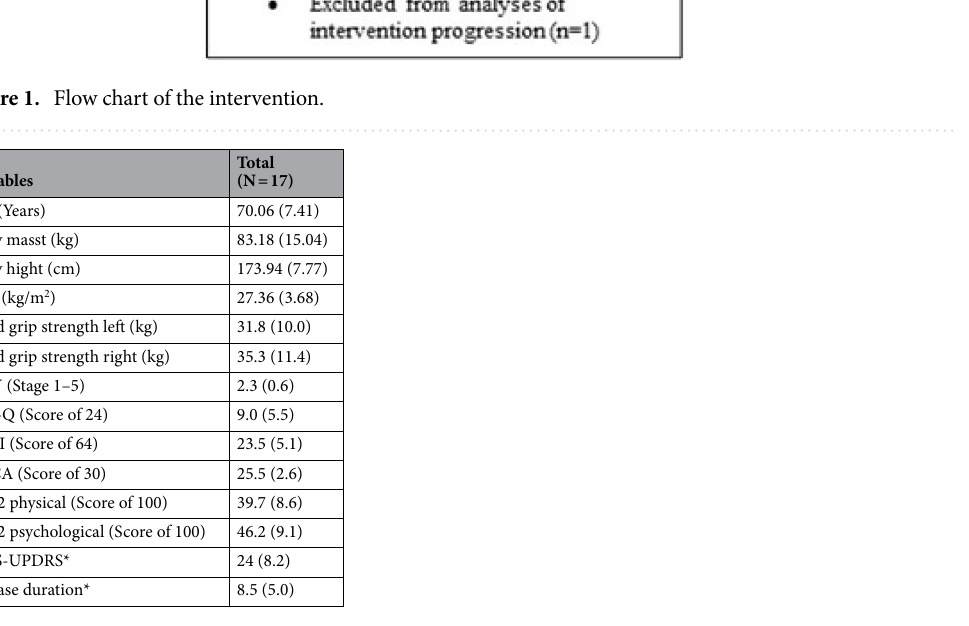
Table 2. Characteristics of patients at baseline (N = 17). BMI Body Mass index; H&Y = Hoehn & Yahr Stage; FoG-Q = Freezing of Gait Questionnaire; FES-I = Falls Efficacy Scale International Version; MoCA =